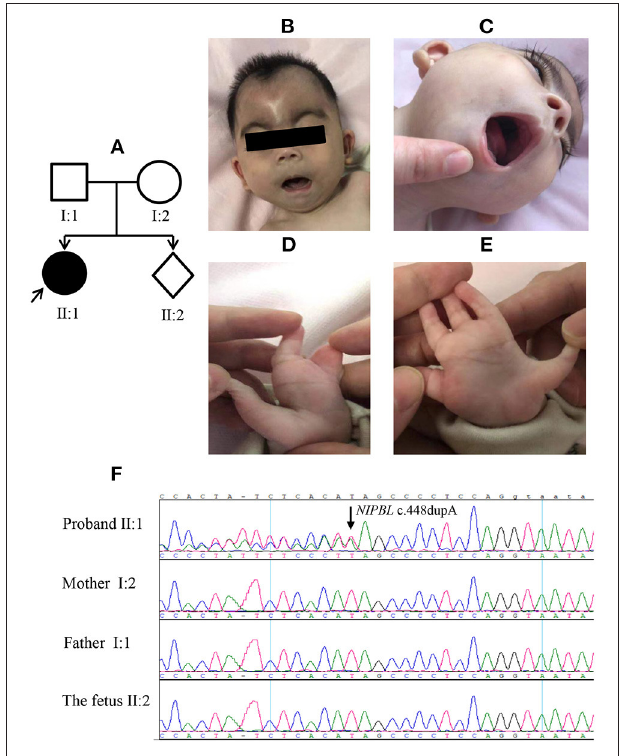
FIGURE 3 | Clinical features of the proband and Sanger sequencing results in case 3. The proband (A , II: 1) presented with typical facial features of Cornelia de Lange syndrome (CdLS) and upper limber defects (B–E) . The (F) panel shows the Sanger sequencing results of NIPBL c.448dupA mutation in the